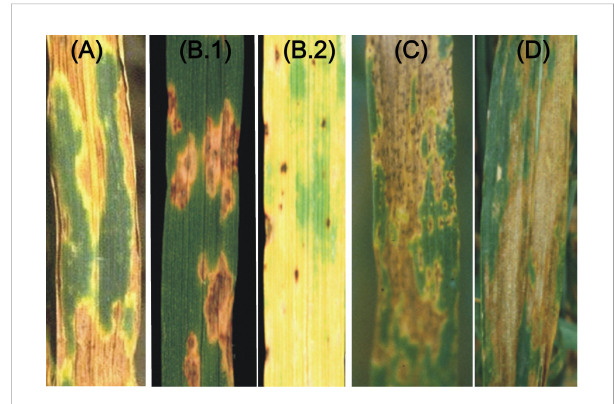
diseases. (A) SNB; (B) TS ( B.1 and B.2 showing necrosis and chlorosis); (C) SB and (D)